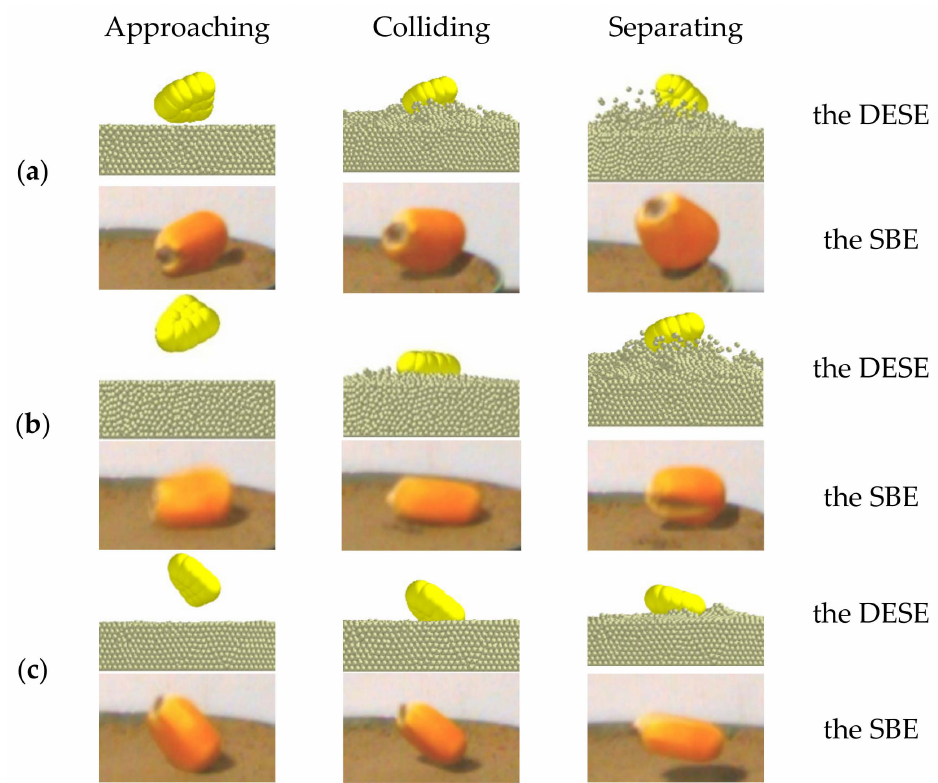
Figure 10. Comparison of movement status. ( a – c ) represent three groups of comparative tests, in each group of tests the falling height and contact position of corn seeds in the DESE and the SBE are the same, to compare the movement state of seeds in the DESE and the